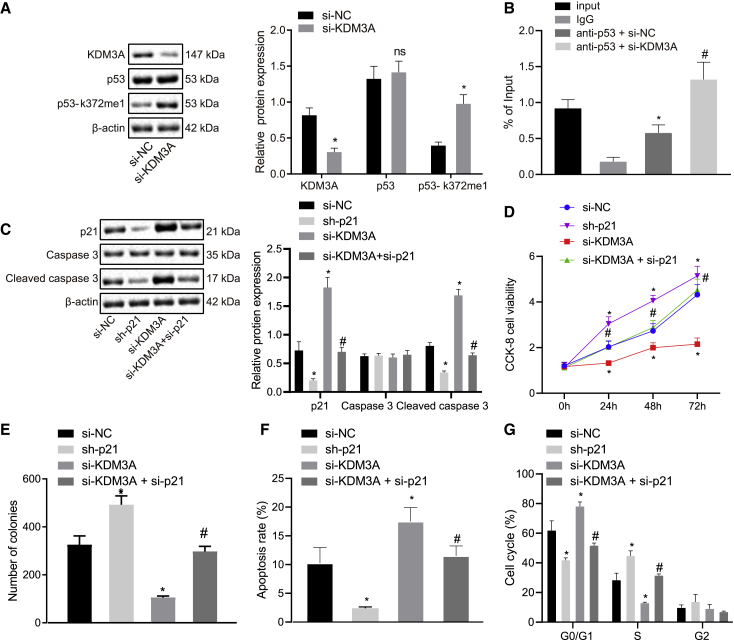
KDM3A functioned as an oncogene in NSCLC by inhibiting p21(A) Western blots and quantification of KDM3A, p53-k372me1, and p53 in H1299 cells, normalized to β-actin expression. (B) p21 was immunoprecipitated using p53 antibody relative to IgG by ChIP assays. (C) Western blots and quantification of p21, cleaved caspase-3, and caspase-3 in H1299 cells, normalized to β-actin expression. (D) H1299 cell viability was measured by CCK-8 assays. (E) Numbers of colonies derived from H1299 cells. (F) H1299 cell apoptosis determined by annexin V/PI-labeled flow cytometric analysis. (G) H1299 cell cycle determined by flow cytometric analysis. ∗p < 0.05 (compared with scramble siRNA or IgG antibody) and #p < 0.05 (compared with si-KDM3A or anti-p53 with si-NC) by unpaired t test, Tukey’s test-corrected one-way ANOVA, or Bonferroni-corrected repeated-measures ANOVA.